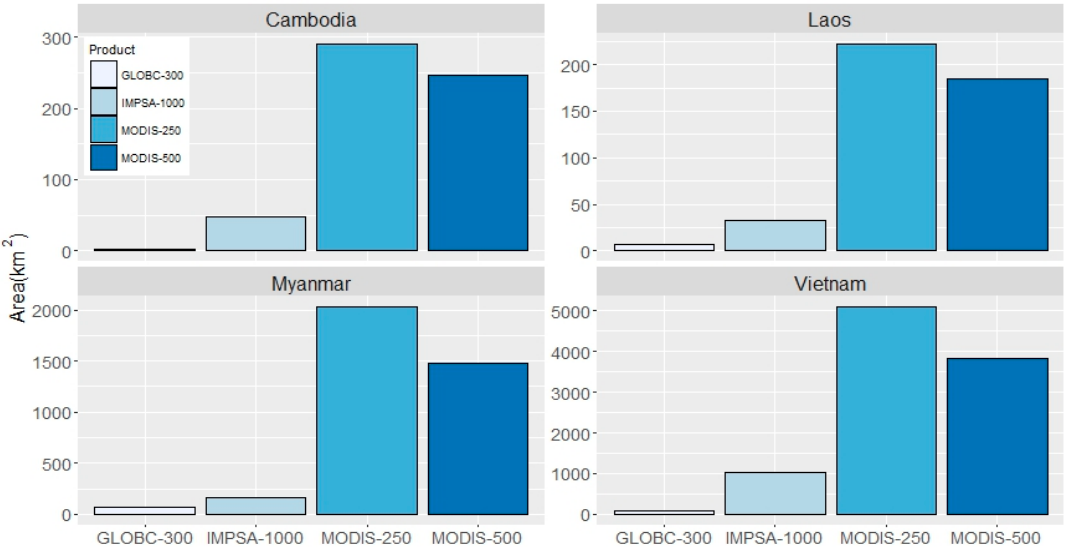
Figure 1. Comparison of the estimated urban built-up area in Cambodia, Laos, Myanmar, and Vietnam among different coarse resolution products. GLOBC-300 is the 300-m resolution the GlobCover land cover in 2009 by the European Space Agency [18]; IMPSA-100 is the 1000-m resolution global impervious surface area in 2010, which was converted to urban built-up by applying a 20% threshold [16,19]; MODIS-500 is the 500-m resolution global land cover developed from MODIS images in 2010 [13,17], and MODIS-250 is based on the statistics from the 250-m resolution urban built-up area developed with MODIS images in 2010 [11,20].